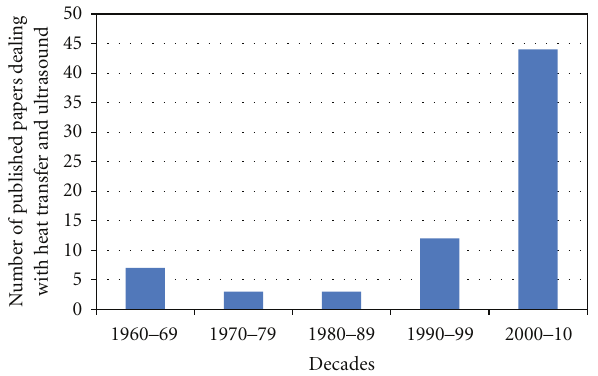
Figure 5: Evolution of the number of published papers per decade dealing with heat transfer enhancement by